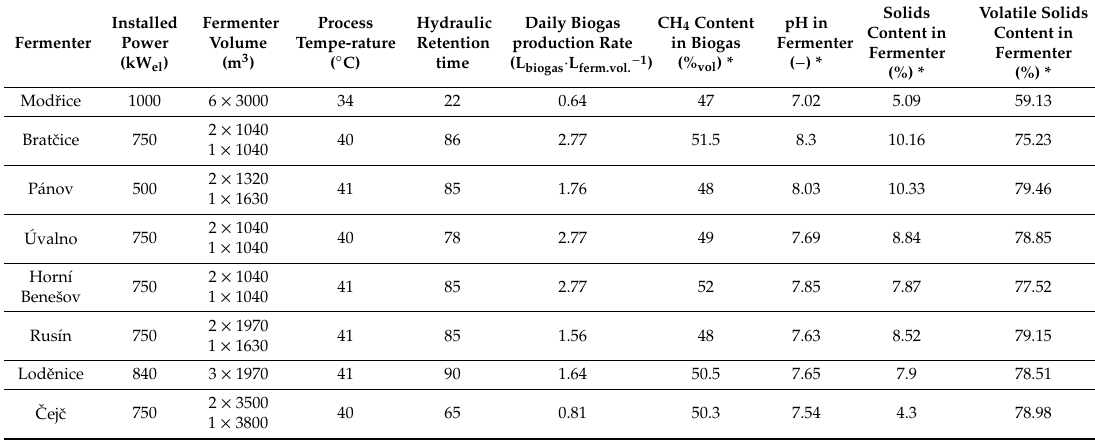
Table 1. The investigated scale anaerobic